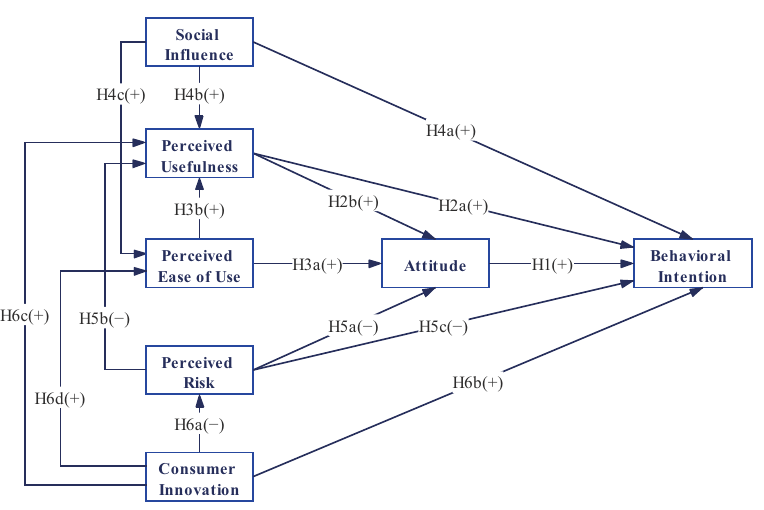
Figure 1. Proposed theoretical